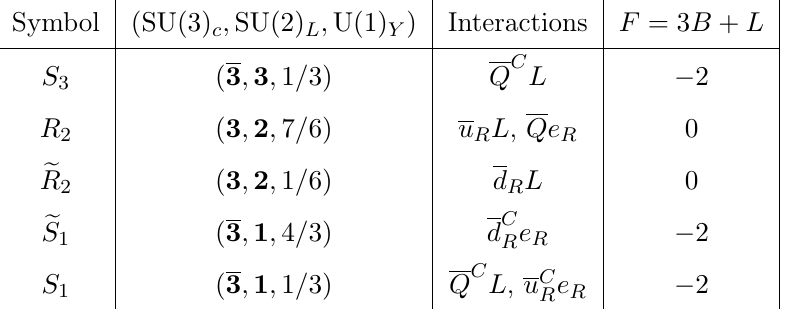
m q =m (cid:22) ) due to a /